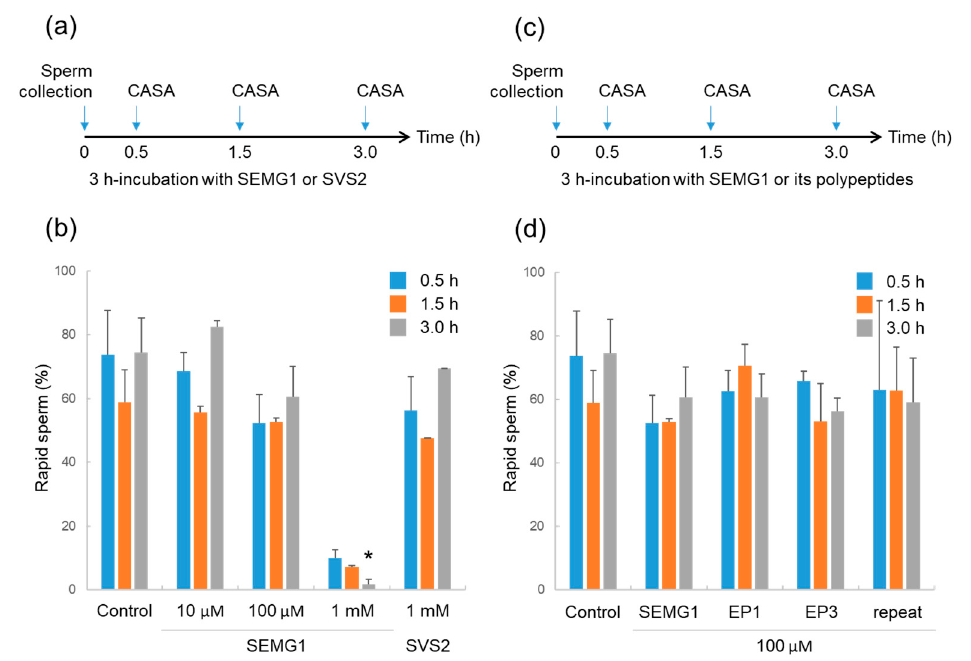
Figure 1. Mouse sperm motility during in vitro incubation for 3 h with human Semenogelin 1 (SEMG1) and its polypeptides. ( a ). Experimental design for determining the appropriate concentration of SEMG1 on epididymal sperm. ( b ). Rates of epididymal sperm displaying rapid motility during 3 h of incubation ( n = 3). Data are expressed as the average ± standard error of the mean. * p < 0.05, compared with control for the same time. ( c ). Experimental design for testing the effect of human SEMG1 fragmented polypeptides on mouse sperm motility. ( d ). Rates of epididymal sperm displaying rapid motility after 3 h incubation ( n = 3). Data are expressed as the average ± standard error of the mean.